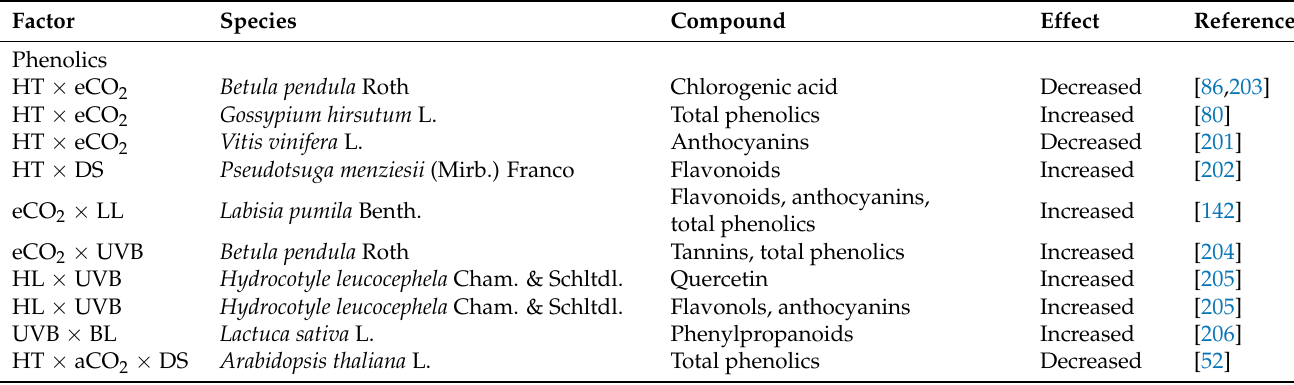
Table 6. Effects of multiple environmental factors on plant secondary